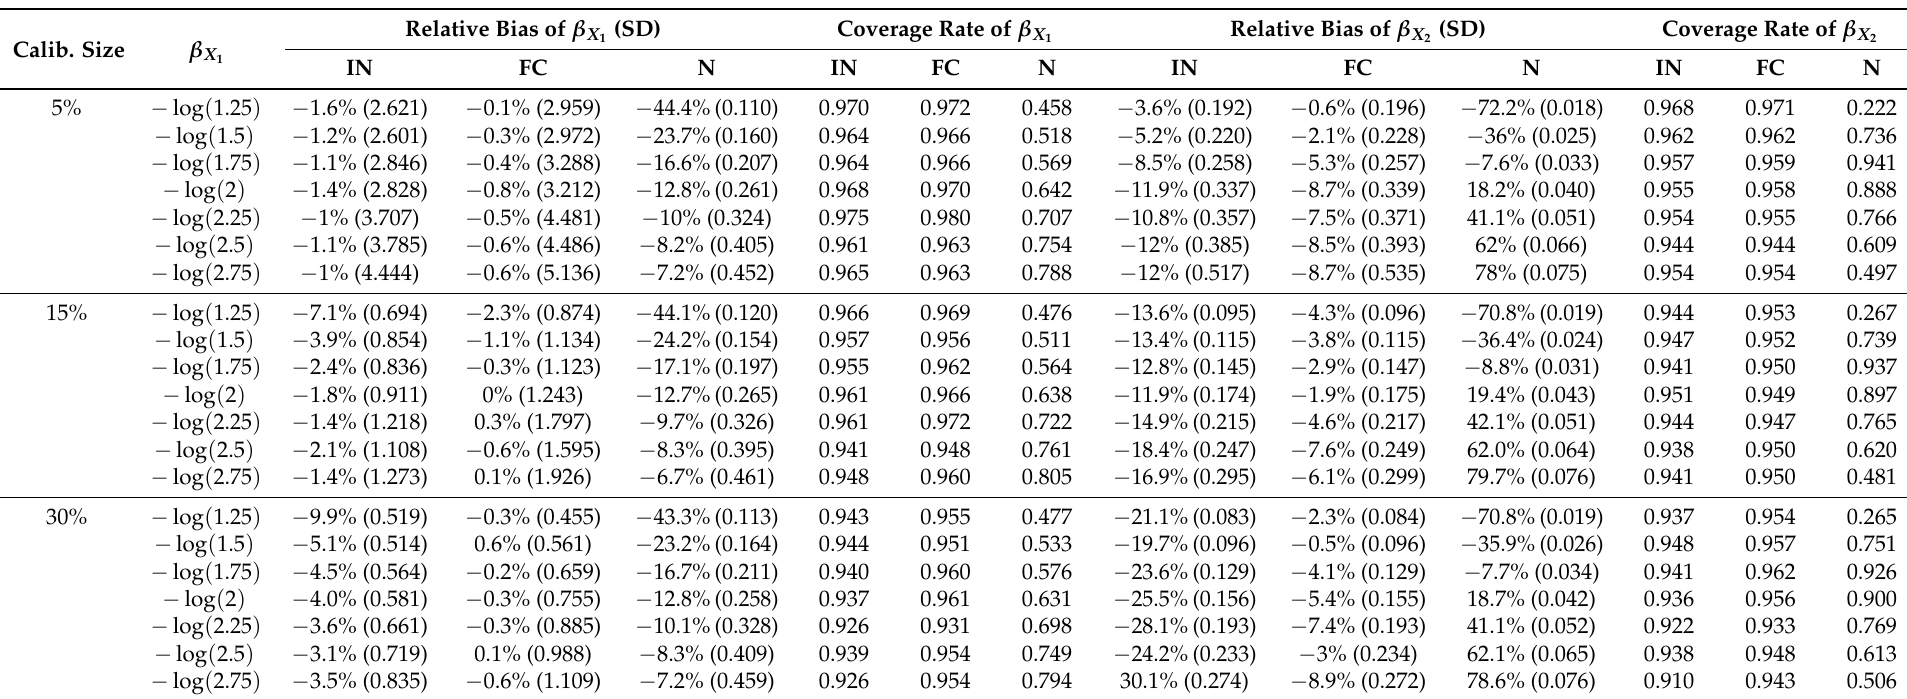
(cid:16) (cid:17) = β + β ( X ) + β ( X ) for Internalized calibration (IN), Full Y sji = 1 | X sji under the model P X 1 f 1 X 2 f 2 sji sji 0 sj X − β , and the reported value in the table is the average over the 1000 simulation replicates. β is fixed at 2